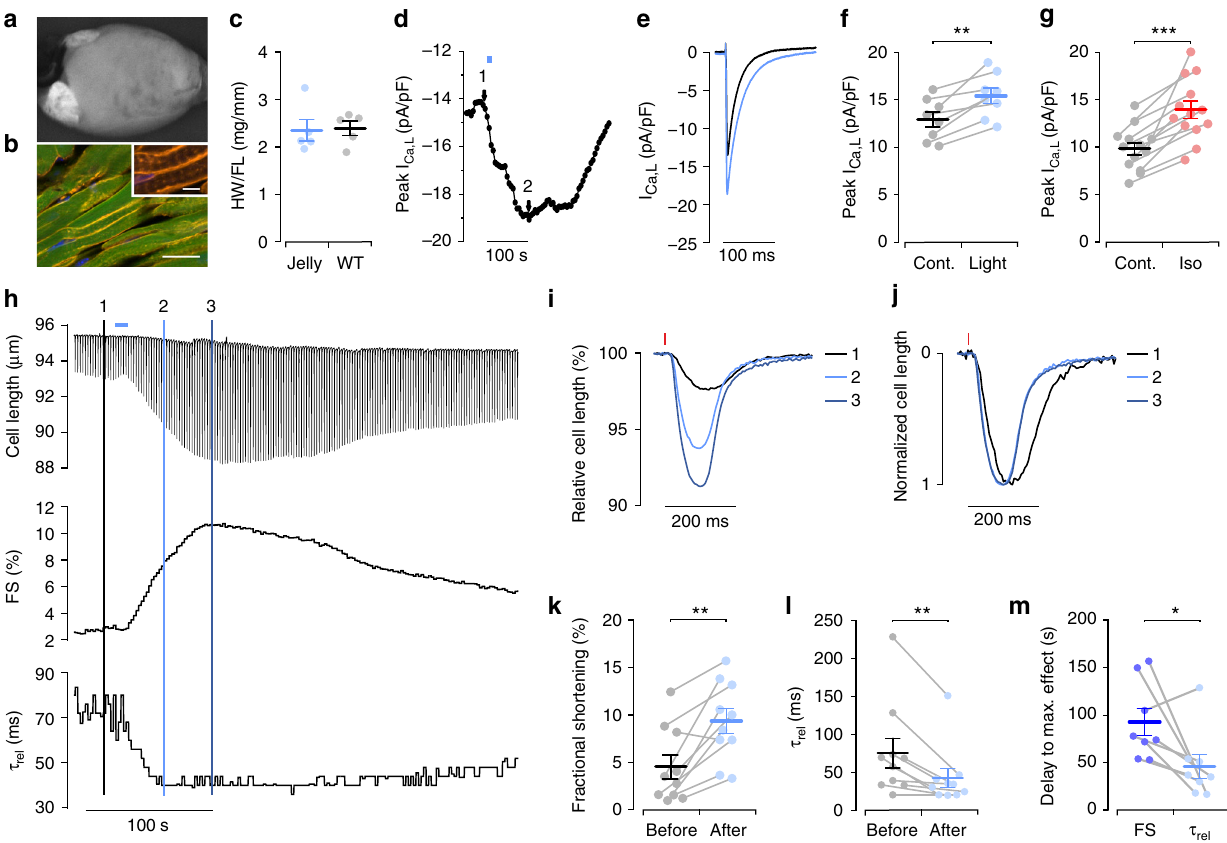
Fig. 4 JellyOp function in isolated mouse ventricular cardiomyocytes. a Overview of GFP fl uorescence in an intact JellyOp mouse heart. b Section of the left ventricle with membrane-bound JellyOp-1D4 epitope signals (yellow) in GFP (green) positive cardiomyocytes (nuclear staining in blue, bar: 20 µ m, insert: 5 µ m). c Heart weight (HW) to femur length (FL) ratio in JellyOp (Jelly) and wild-type (WT) mice (>6 months of age, n = 5, two-sided unpaired Student's t -test: p = 0.8915). d , e Representative changes in peak L-type Ca 2 + current ( I Ca,L ) in a JellyOp ventricular cardiomyocyte upon illumination ( d , blue